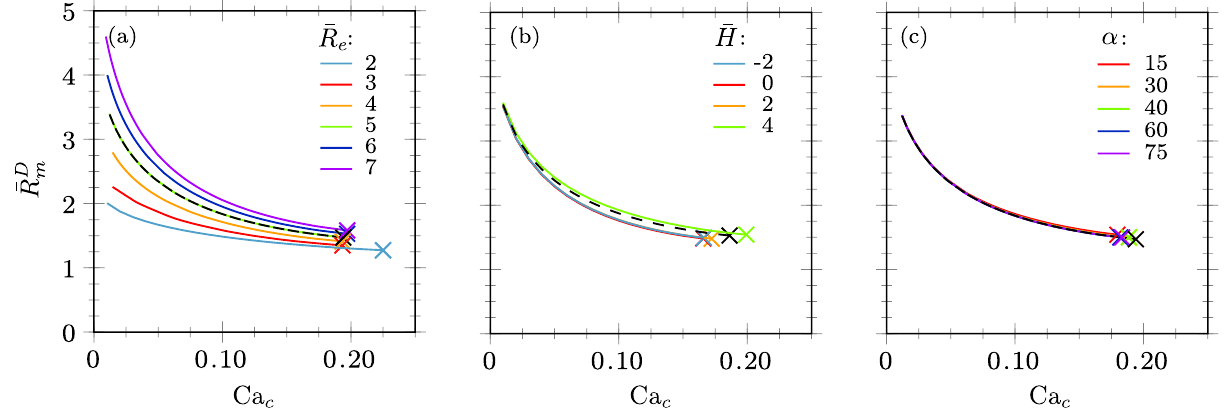
Figure 12. Influence of the geometrical parameters on the droplet size for (cid:31) = 1 / 23 : ( a ) the unconfinement parameter ¯ R e , ( b ) the non-embedment parameter ¯ H and ( c ) the nozzle inclination α are varied around the nominal values of couple 1 represented in dashed black line for ¯ R e = 5 , ¯ H = 3.33 and α = 50 ◦